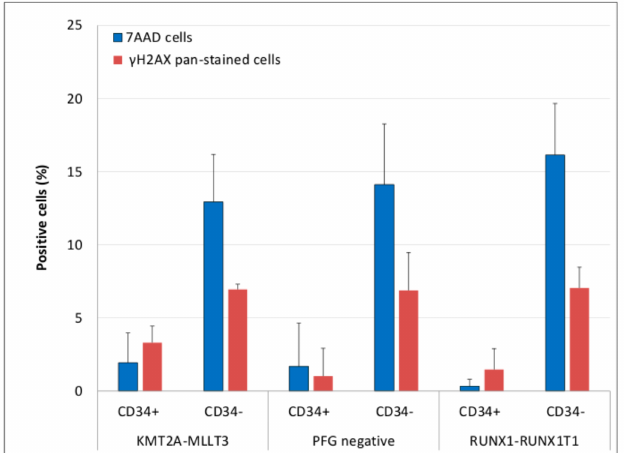
Figure 6. Apoptosis in CD34 +/ − cells from PFG +/ − probands. The figure shows apoptosis as measured by the percentage of γ H2AX pan-stained and 7-AAD + cells in CD34 + HSPCs and CD34 − lymphocytes from PFG +/ − probands. Mean values from three KMT2A-MLLT3, RUNX1-RUNX1T1 and PFG negative samples are shown along with the standard